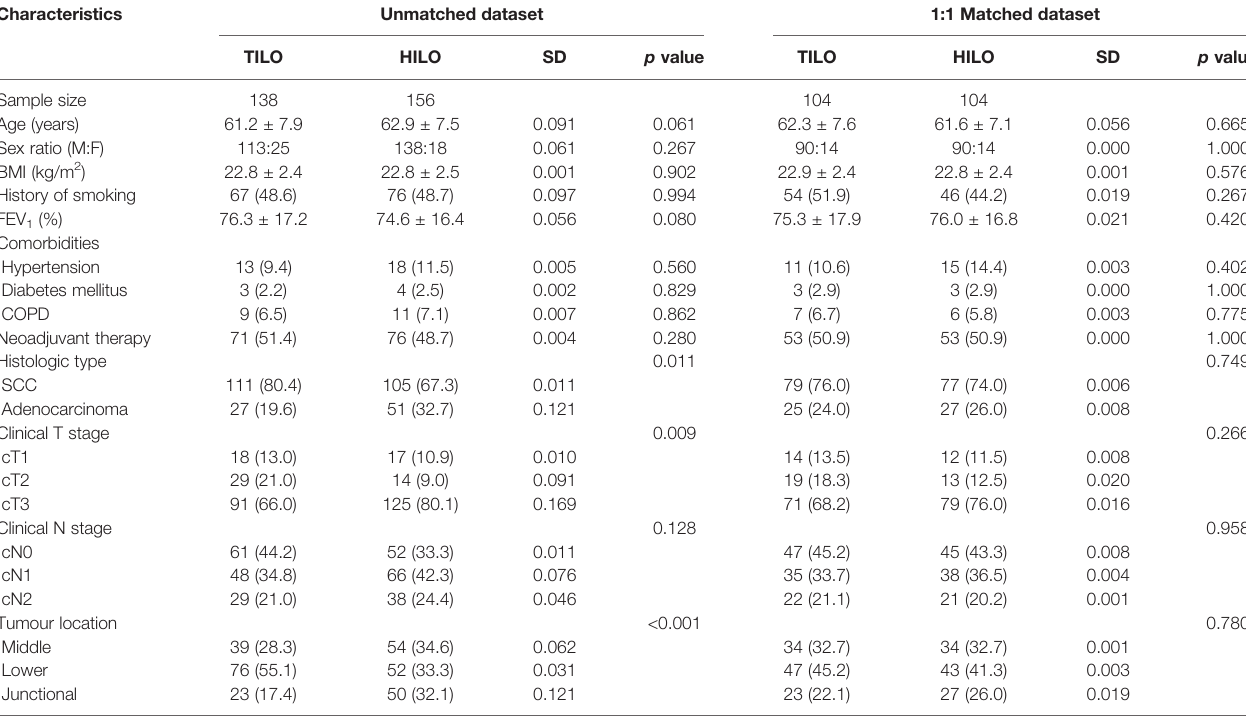
TABLE 1 | Baseline characteristics of patient population.